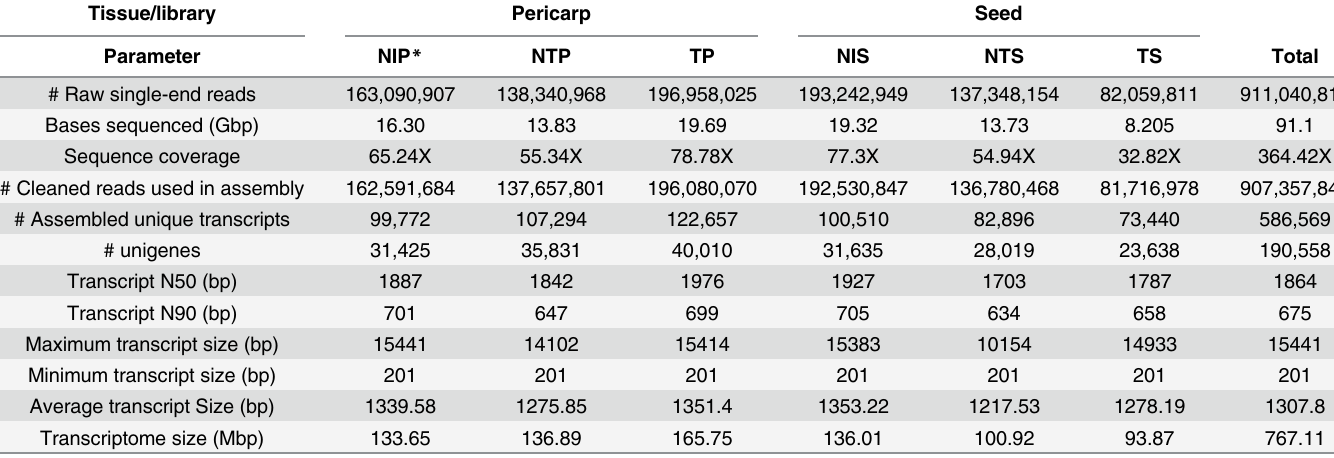
Table 1. Sequence and assembly statistics of six cotton libraries with/without A . flavus